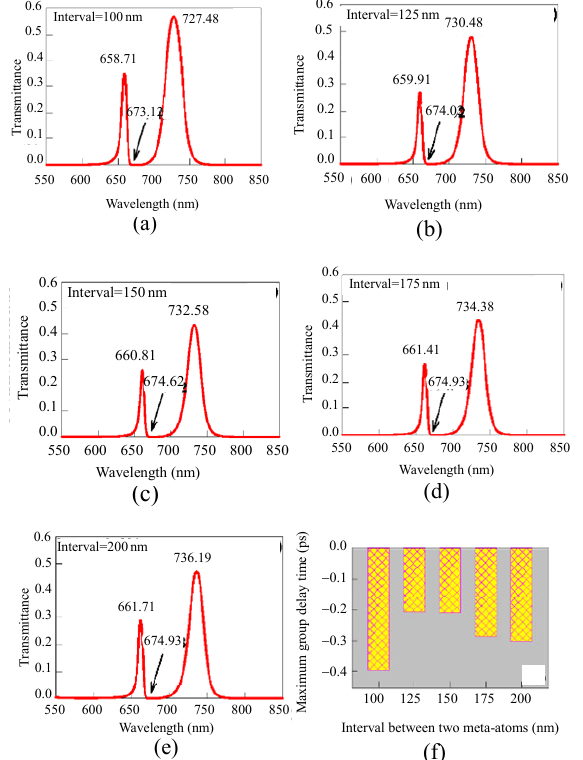
Fig. 5 Transmission spectra (a)  (e) and the maximum group delay time (f) of the cascade device for different distances.